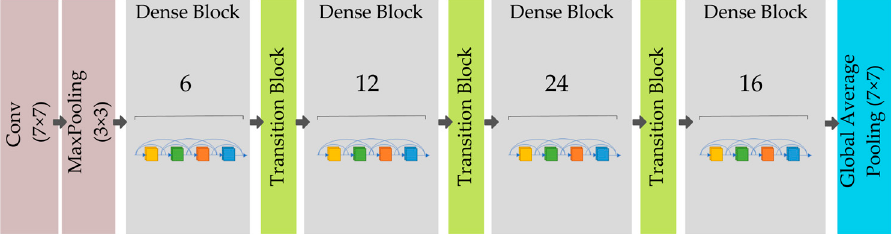
Figure 8. Example of a deep DenseNet with three dense blocks.